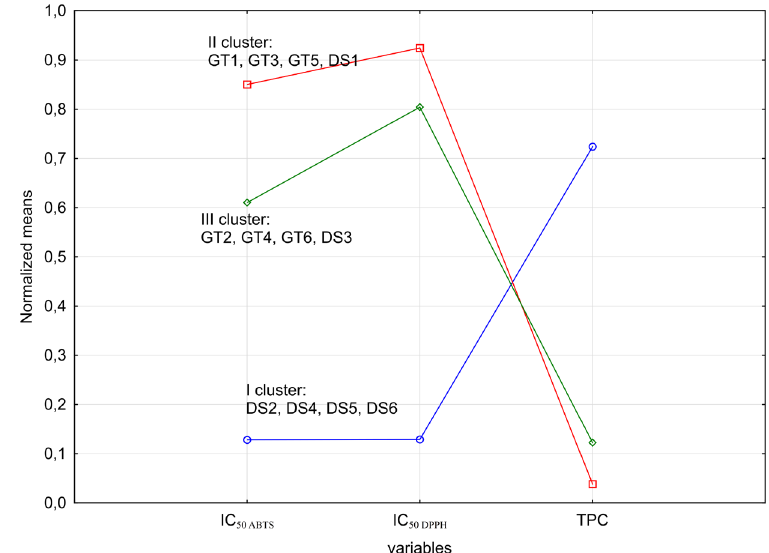
Figure 3. Three clusters obtained by k-means clustering algorithm. Table 2. Factor loadings for spectrophotometric